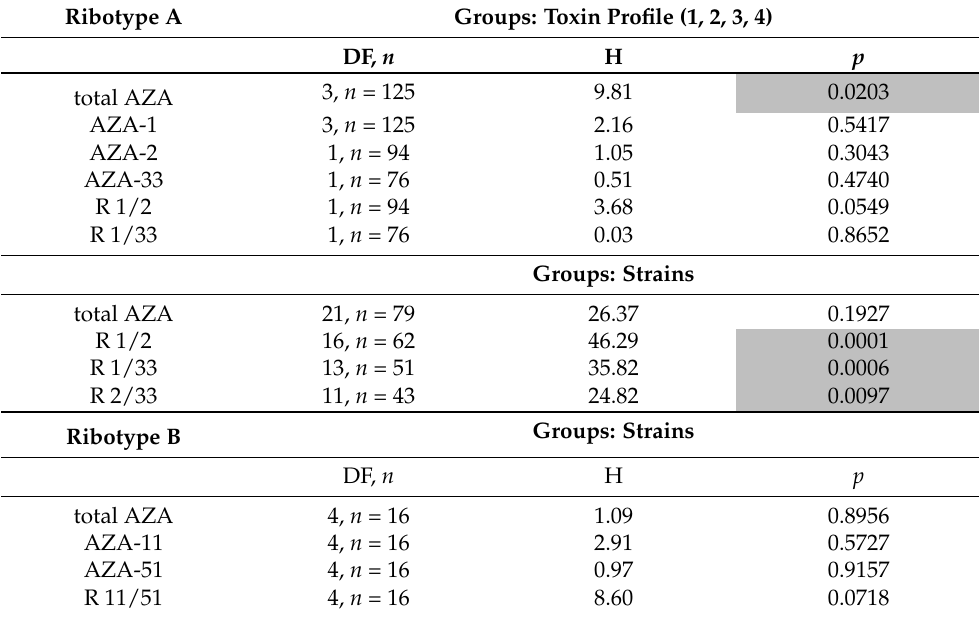
Figure 9. Azadinum spinosum ribotype A strains. Box-Whisker plots ( A , B ) and summary statistics ( C ) of all analyses (including repeated analyses of single strains) of AZA cell quota ( A ) and AZA ratios ( B ). Std = standard deviation. Table 5. Summary statistics, analysis of variance (ANOVA) Kruskal–Wallis test. Significance level <0.05 are highlighted with grey